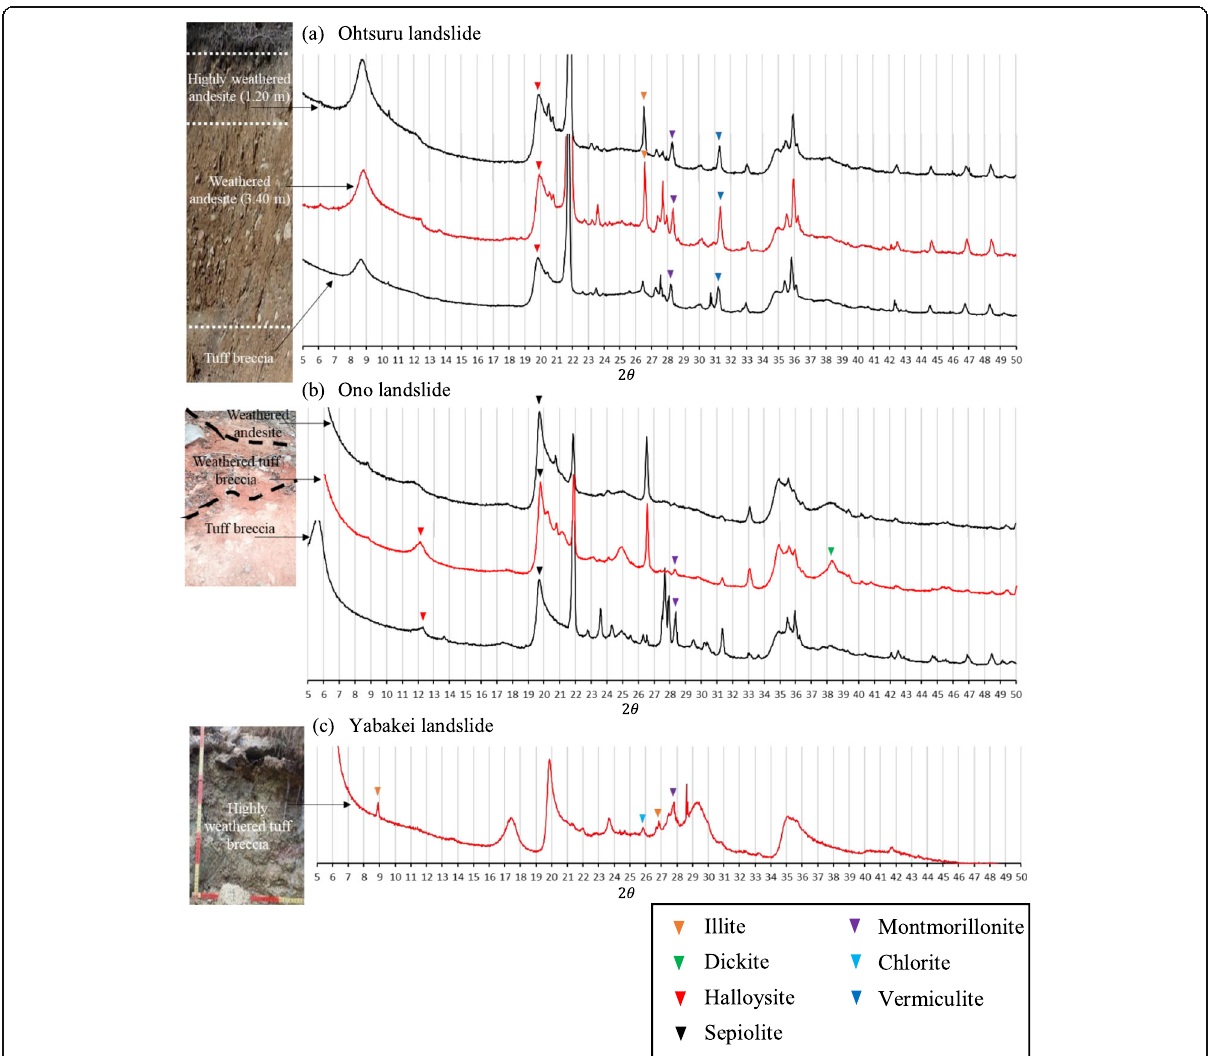
Fig. 15 X-ray diffraction on soil materials in ( a ) Ohtsuru landslide, ( b ) Ono landslide, and ( c ) Yabakei